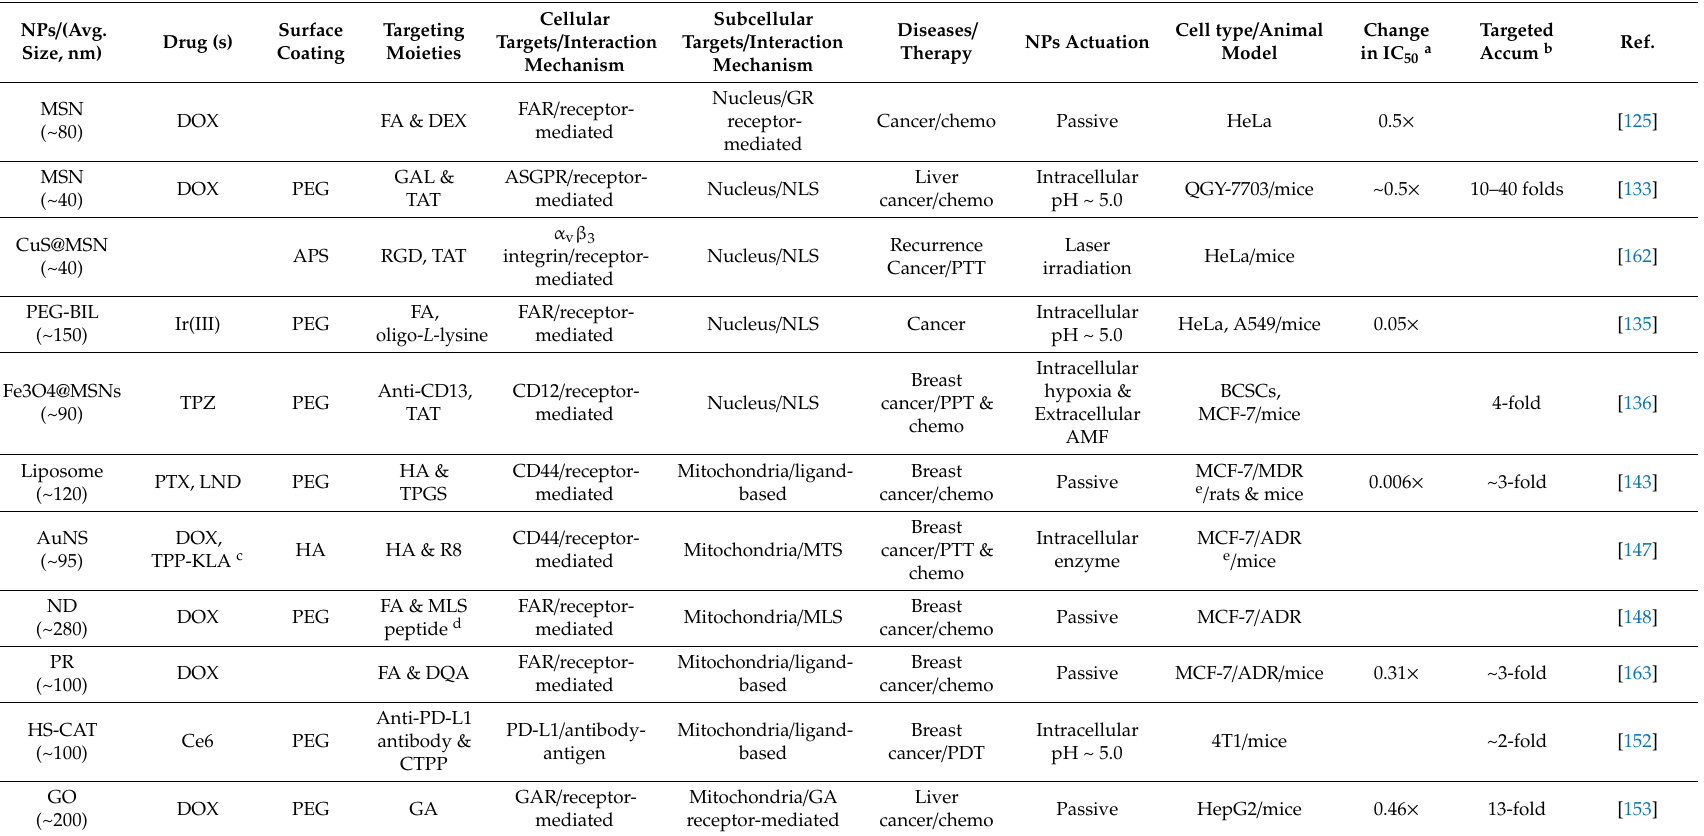
Table A2. Select examples of nanoparticle (NP) formulations for subcellular targeted drug delivery. NPs / (Avg. Size,